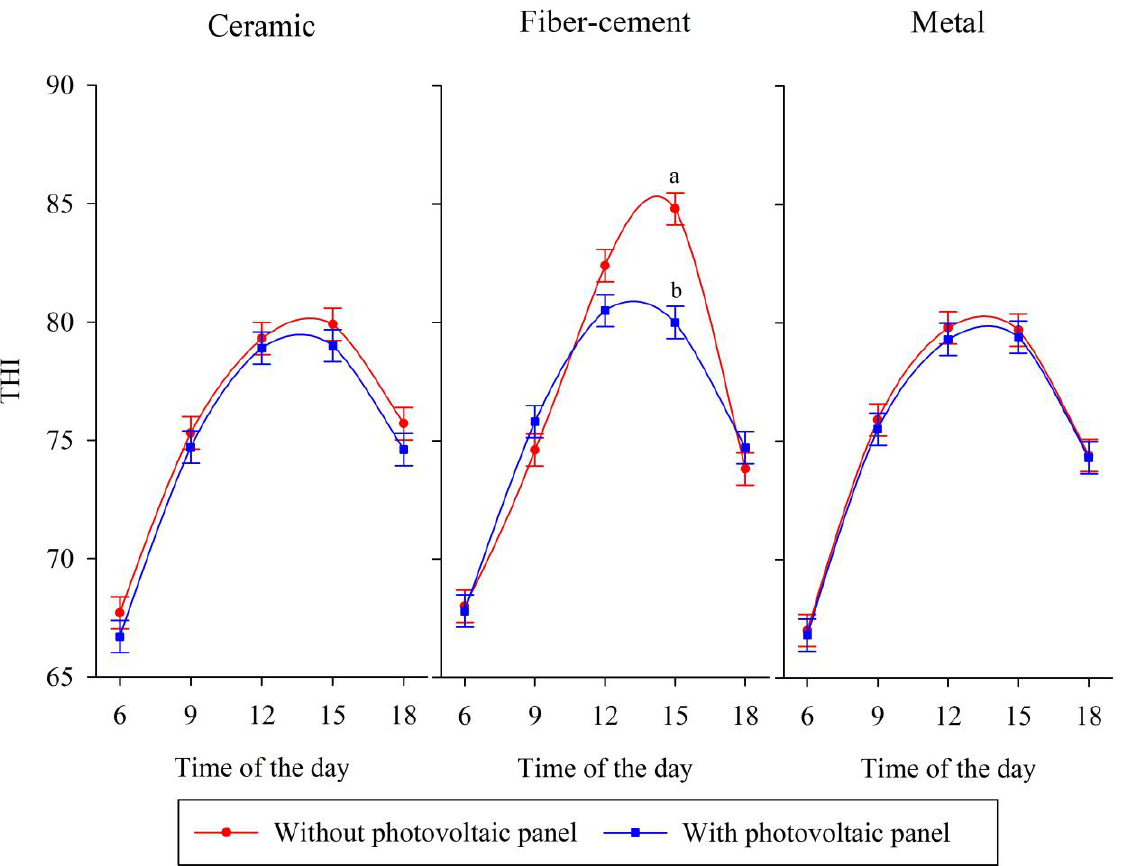
Figure 6. Behavior of the temperature and humidity index (THI) and unfolding of the interaction between the absence and presence of the photovoltaic panel for the three types of tiles analyzed within the hours. Different letters indicate that the values are statistically different, and the absence of a letter indicates that there were no significant differences.